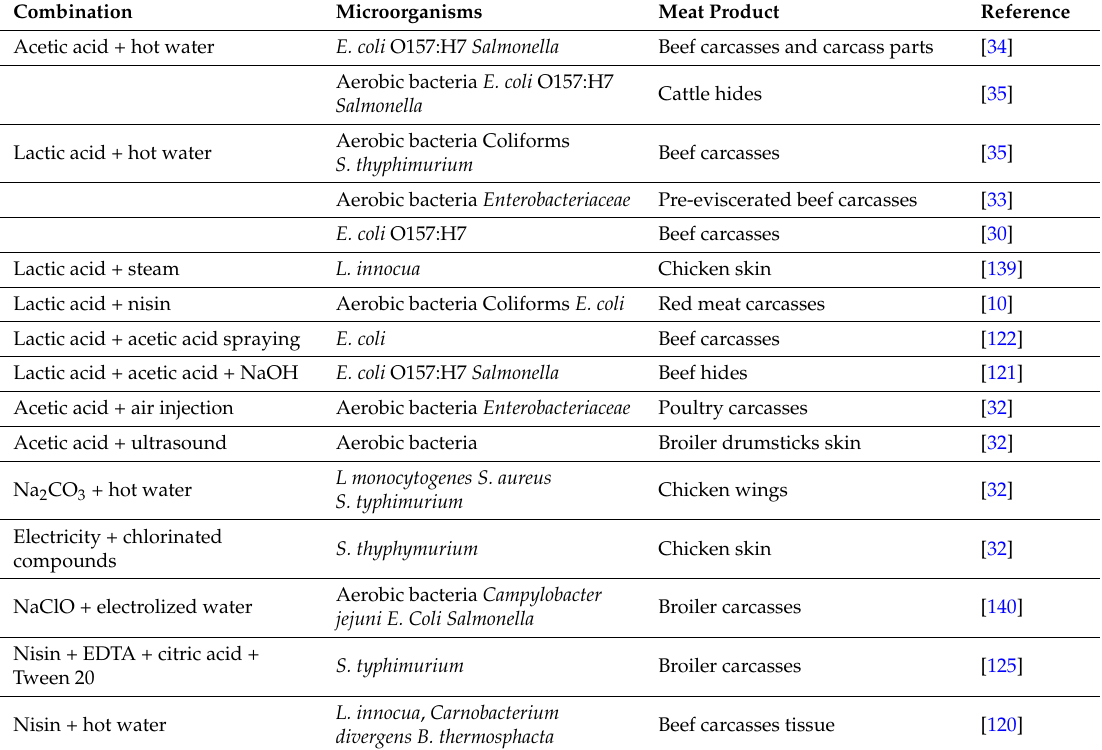
Table 2. Antimicrobial hurdle combinations applied to cattle hides, beef/poultry carcasses, and parts.